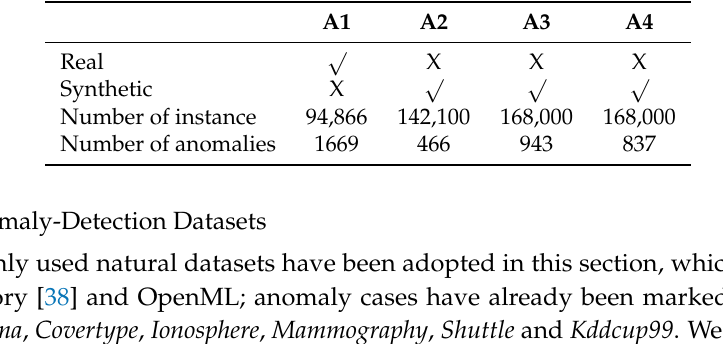
Figure 5. ( a ) Example plot of the Yahoo Webscope S5. ( b ) Plot of the NASA Space Shuttle Valve Dataset. Table 1. Characteristics of each class for the Yahoo Webscope S5.